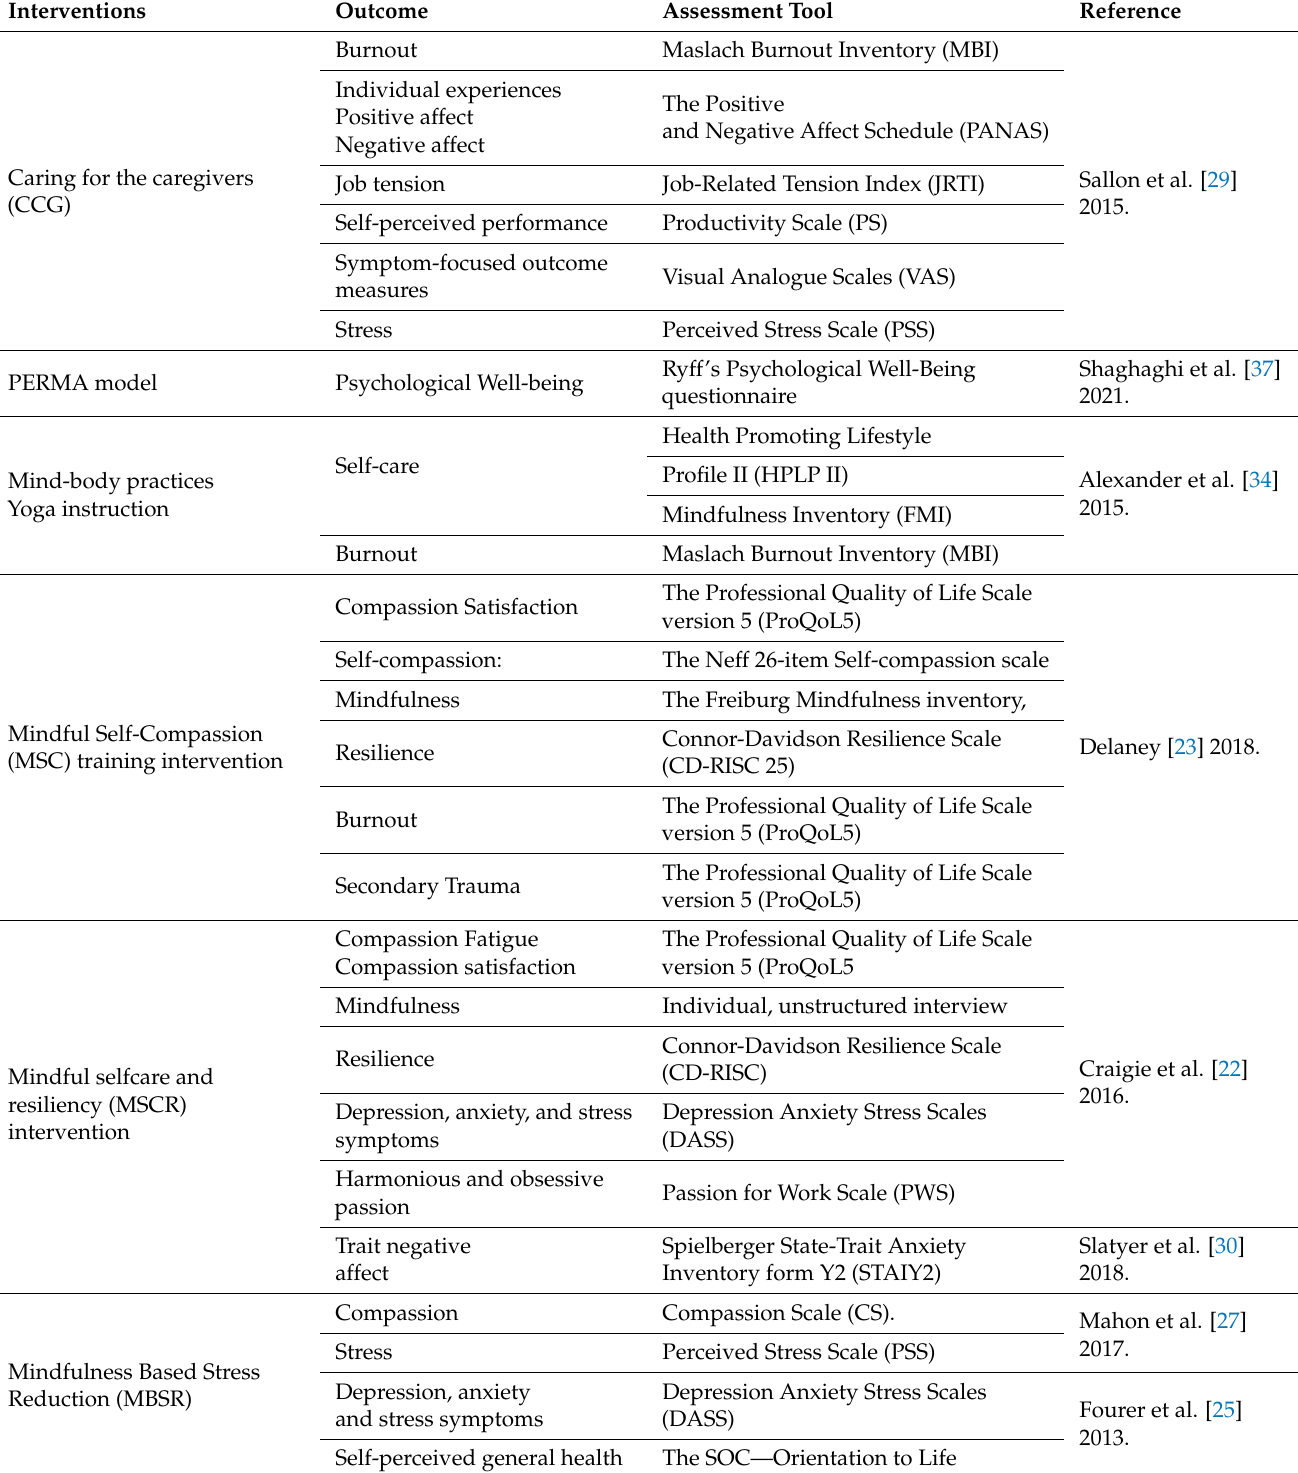
Table 3. Synthesis of